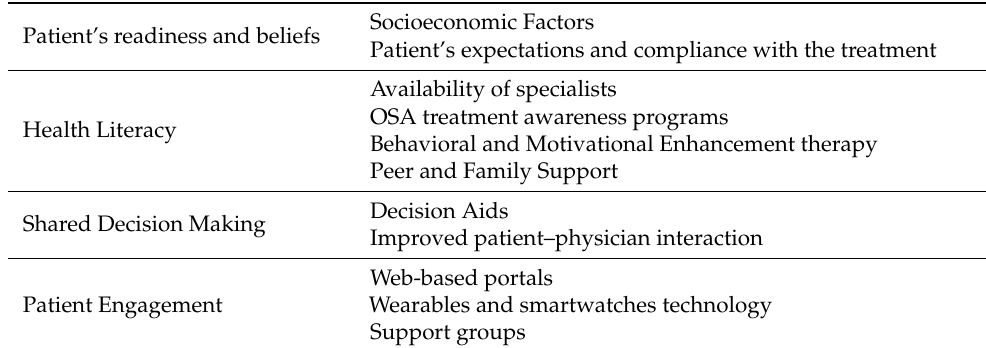
Table 2. Patient-centric approaches to Obstructive Sleep Apnea